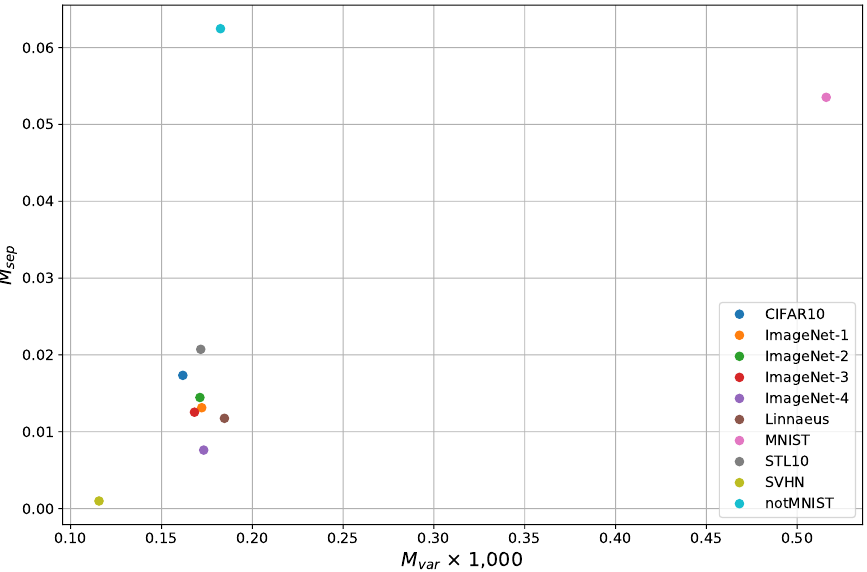
Figure 5. Data quality plot using the two proposed quality